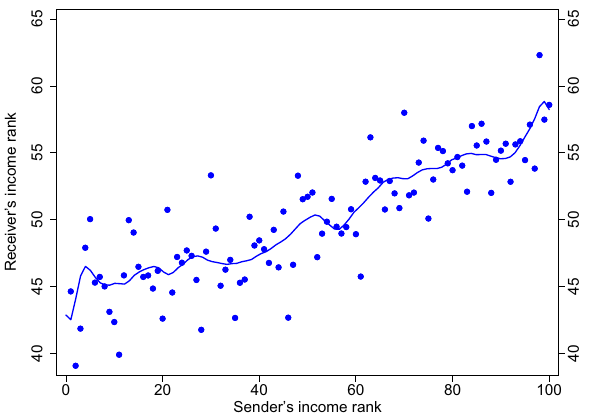
Figure 4. Segregation in the Asian data: average income of sender and receiver. The figure corresponds to Fig. 1a. The figure shows the average income percentile of receivers by the income percentile of the sender as well as local linear smoothing of the relationship. Within tower communication is